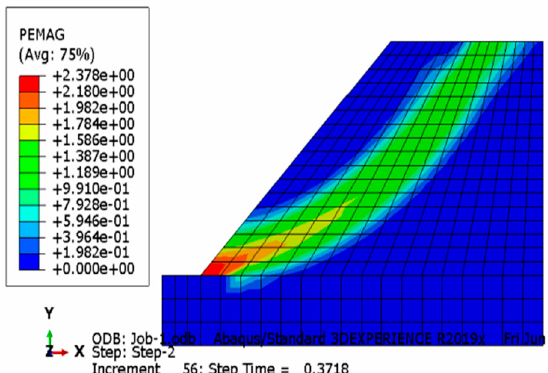
Figure 7. Cloud map of equivalent plastic zone of instability of cutting slope at room temperature .